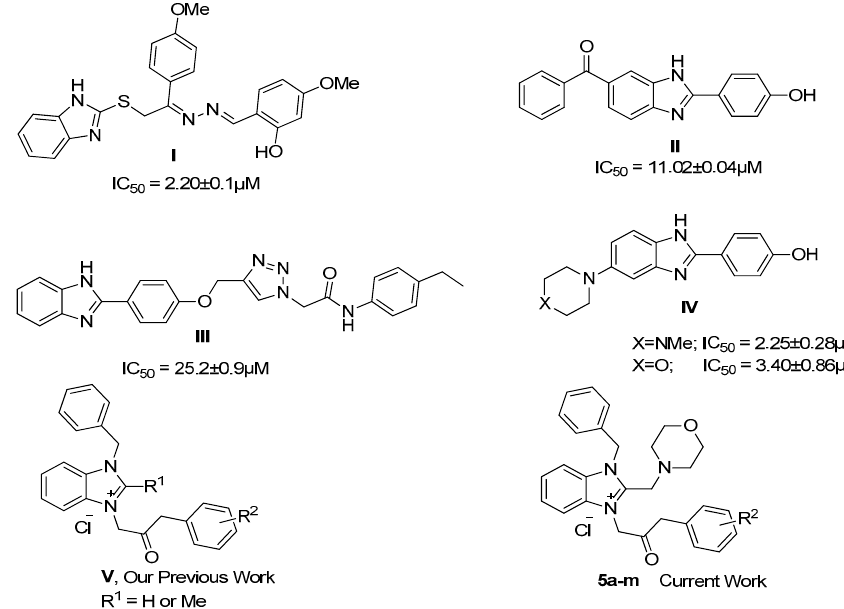
Figure 1. Chemical structures of benzimidazole-based α -glucosidase inhibitors.